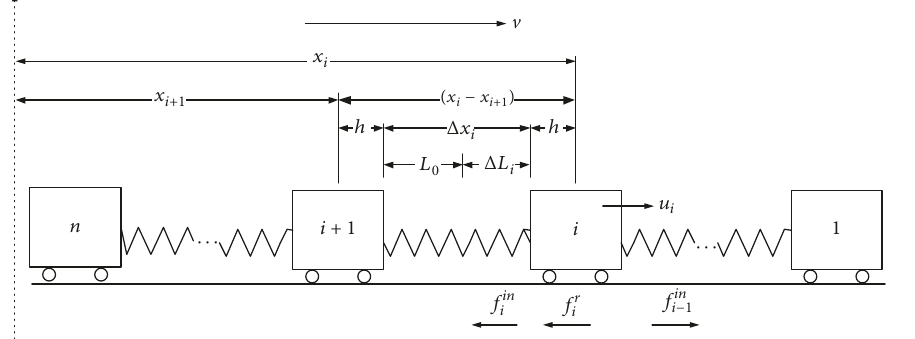
Figure 1: The multiple mass-point model structure of the electric multiple